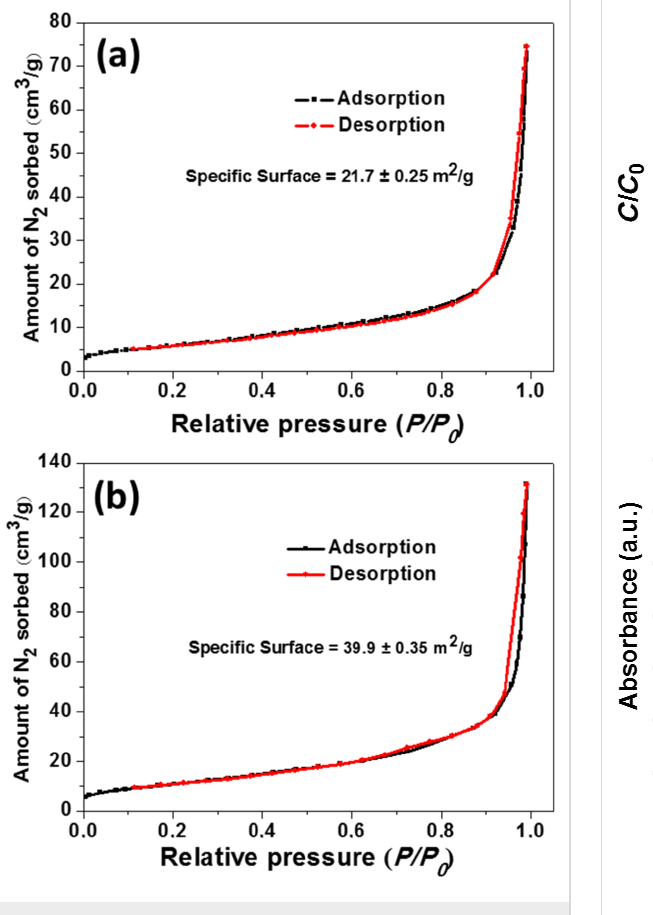
Figure 7: N 2 adsorption/desorption curves at 77 K for ZnO and 5%-doped ZnO rods, giving surface areas of 21.7 and 39.9 m 2 /g, re- spectively. Black and red data correspond to the adsorption and de- sorption branches, respectively.